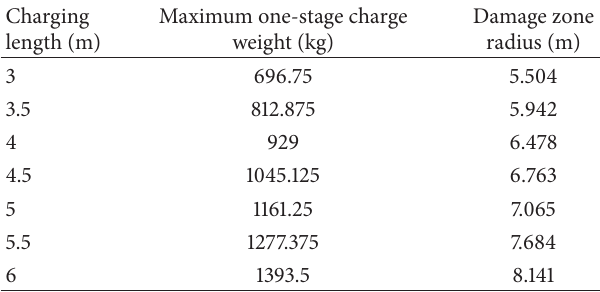
Figure 5: Numerical model with the charging length of 6m. Table 3: Damage zone radiuses with different charge